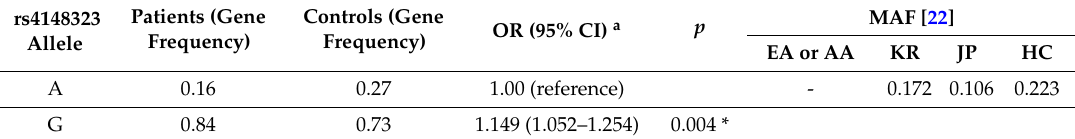
Table 3. The allele frequencies in laryngeal cancer patients and controls and the MAF of rs4148323. rs4148323 Allele